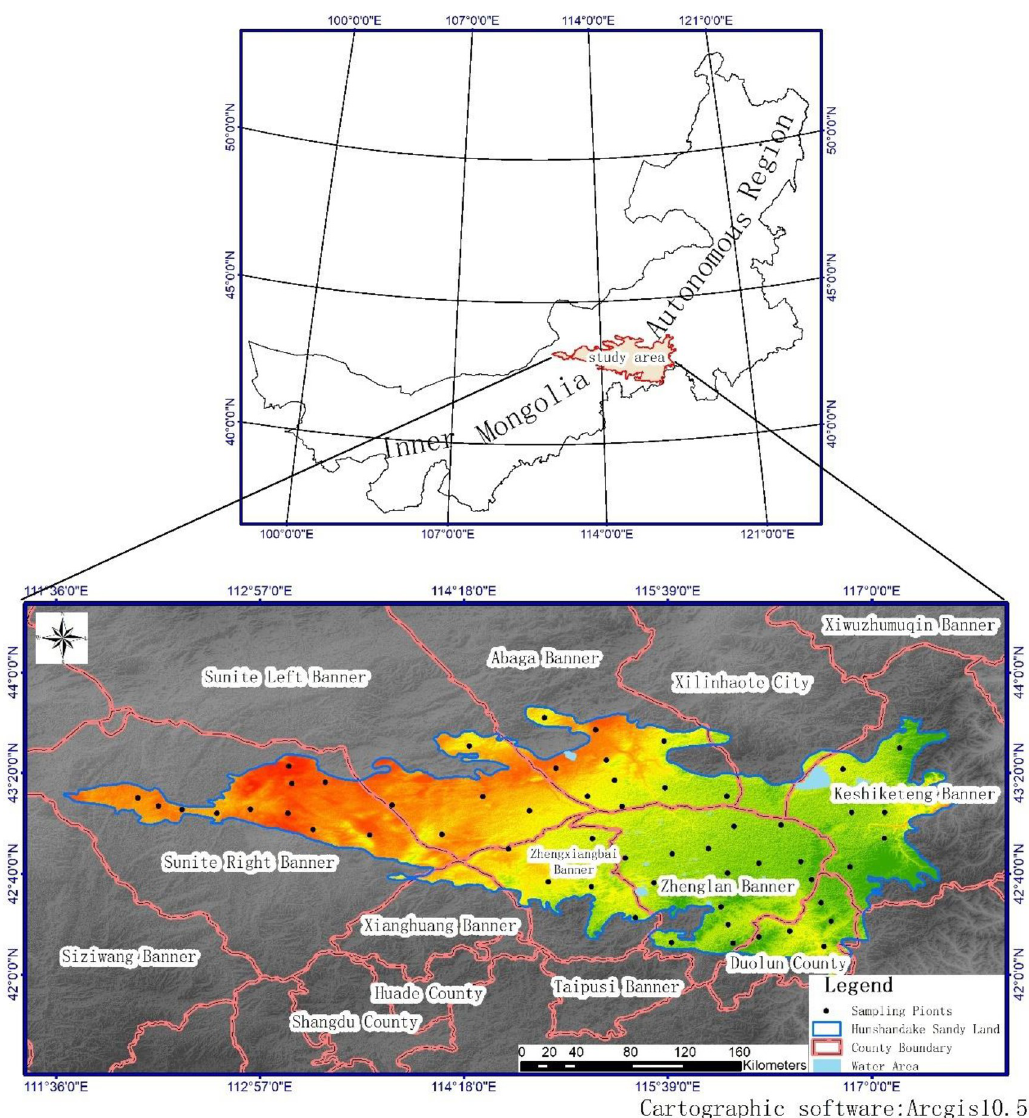
Fig 1. Location of study area and map of sampling points throughout Hunshandake sandy